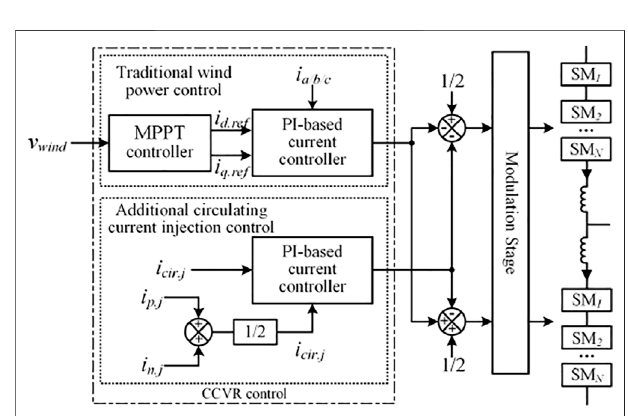
FIGURE 4 | CCVR control for the MMC-based wind energy conversion